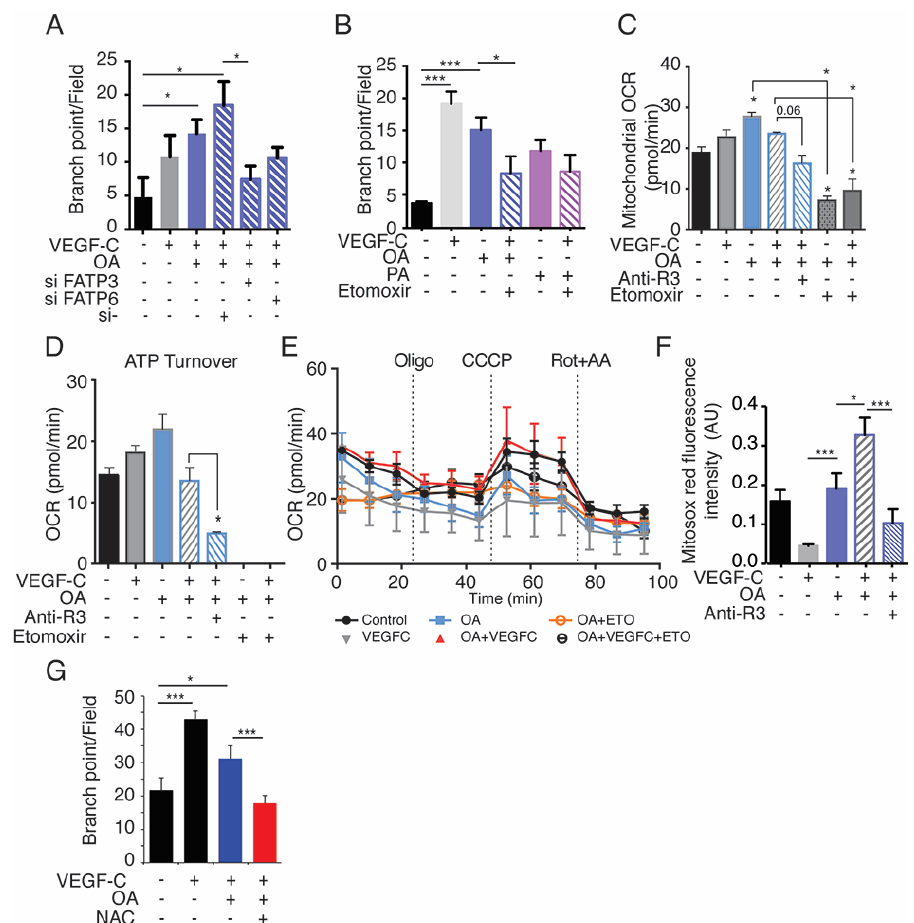
Figure 7. Oleic acid stimulates LEC FAO. ( A ) Quantification of OA+VEGFC stimulated lymphatic branch point formation in the presence of FATP3 and FATP6 siRNA (* p < 0.01). ( B ) Quantification of OA and PA-stimulated lymphatic branch point formation in the presence of etomoxir (*** p < 0.001, * p < 0.05). ( C ) OCR Mito stress test seahorse analysis for VEGFC+OA-stimulated LECs incubated with etomoxir or anti-VEGFR-3 (* p < 0.05). ( D ) OCR analysis showing ATP turnover in OA+VEGFC-stimulated LECs incubated with etomoxir (ETO) or anti-VEGFR-3 (R3) blocking antibody (* p < 0.05). ( E ) OCR Mito Stress test Seahorse profiles for OA+VEGFC-stimulated LECs incubated with etomoxir (ETO) or anti-VEGFR-3 (R3) blocking antibody. ( F ) Total fluorescent intensity of MitoSOX Red in LECs stimulated by VEGFC, OA, and anti-VEGFR3 (* p < 0.05; *** p < 0.001). ( G ) Inhibition of branch point formation by the N-acetyl cysteine (NAC) scavenger of ROS (* p < 0.05; *** p < 0.001).